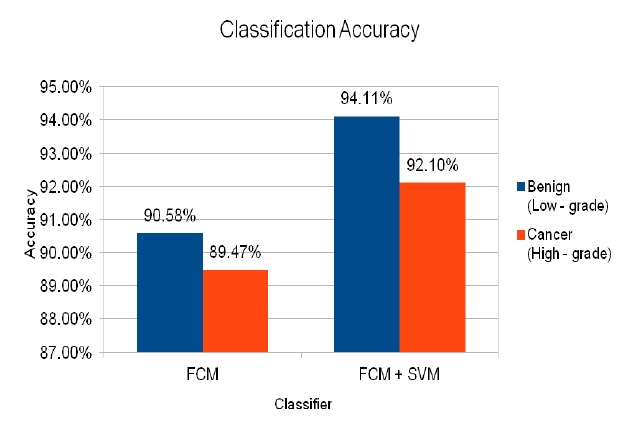
Figure 3 . Classification